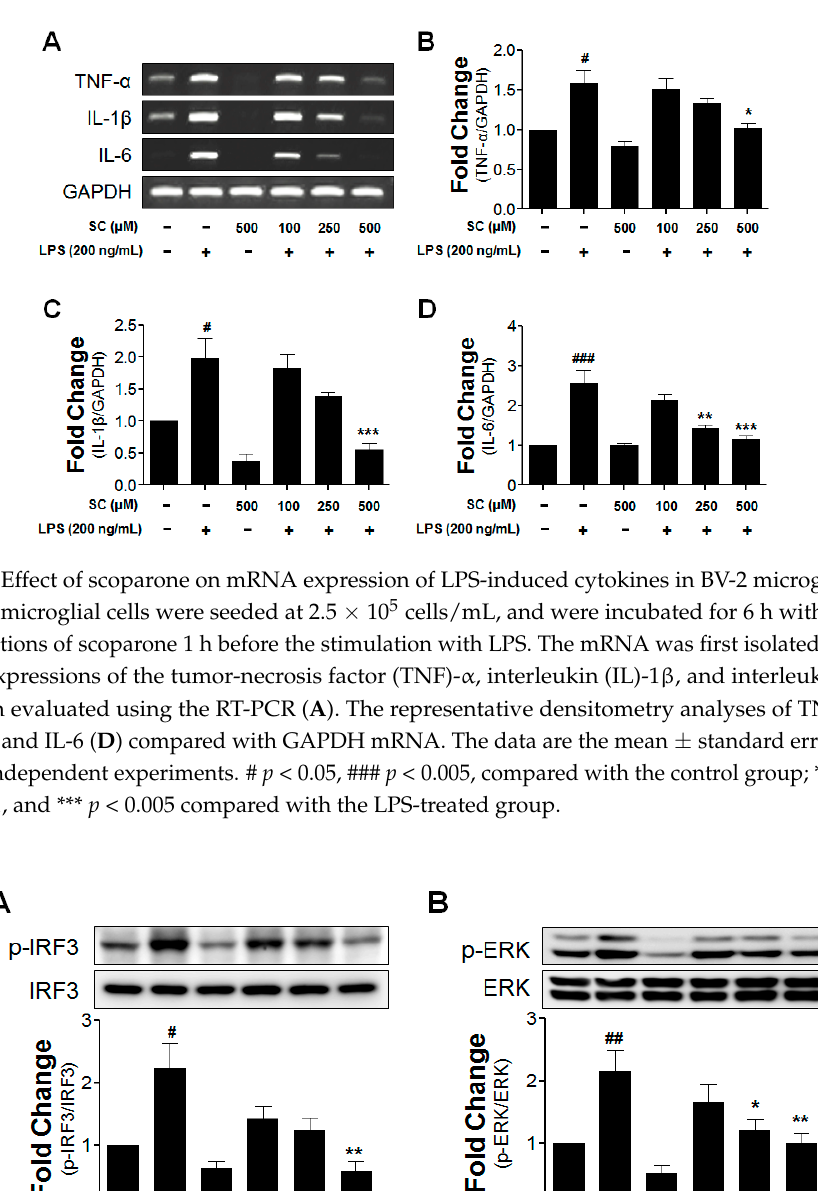
Figure 5. Effect of scoparone on LPS-induced IRF3 and ERK activations induced by LPS in BV-2 microglial cells. The BV-2 microglial cells were seeded at 2.5 × 10 5 cells/mL, and were incubated for 1 h with various concentrations of scoparone 1 h before the stimulation with LPS. The cell lysates were electrophoresed, and the phospho-IRF3 ( A ), phospho-ERK ( B ), and ERK expressions were detected using a specific antibody. # p < 0.05, ## p < 0.01, compared with the control group; * p < 0.05, ** p < 0.01 compared with the LPS-treated group.